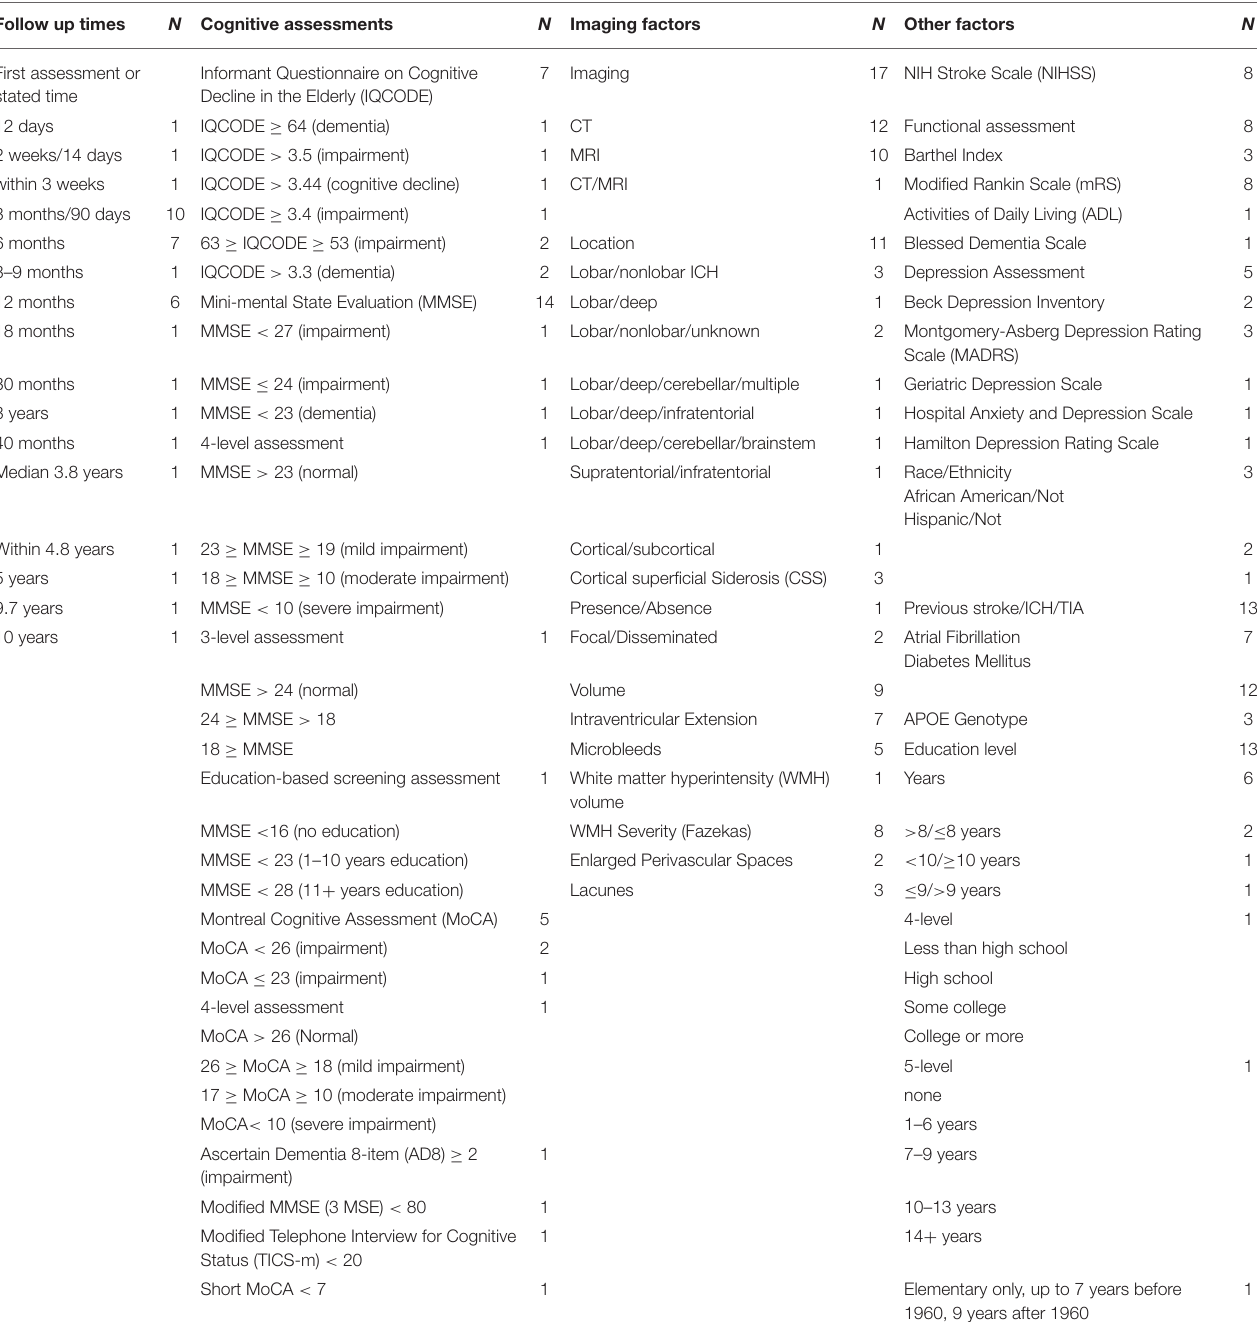
TABLE 5 | The variable testing methods and parameters adopted across studies of post-ICH impairment. Follow up